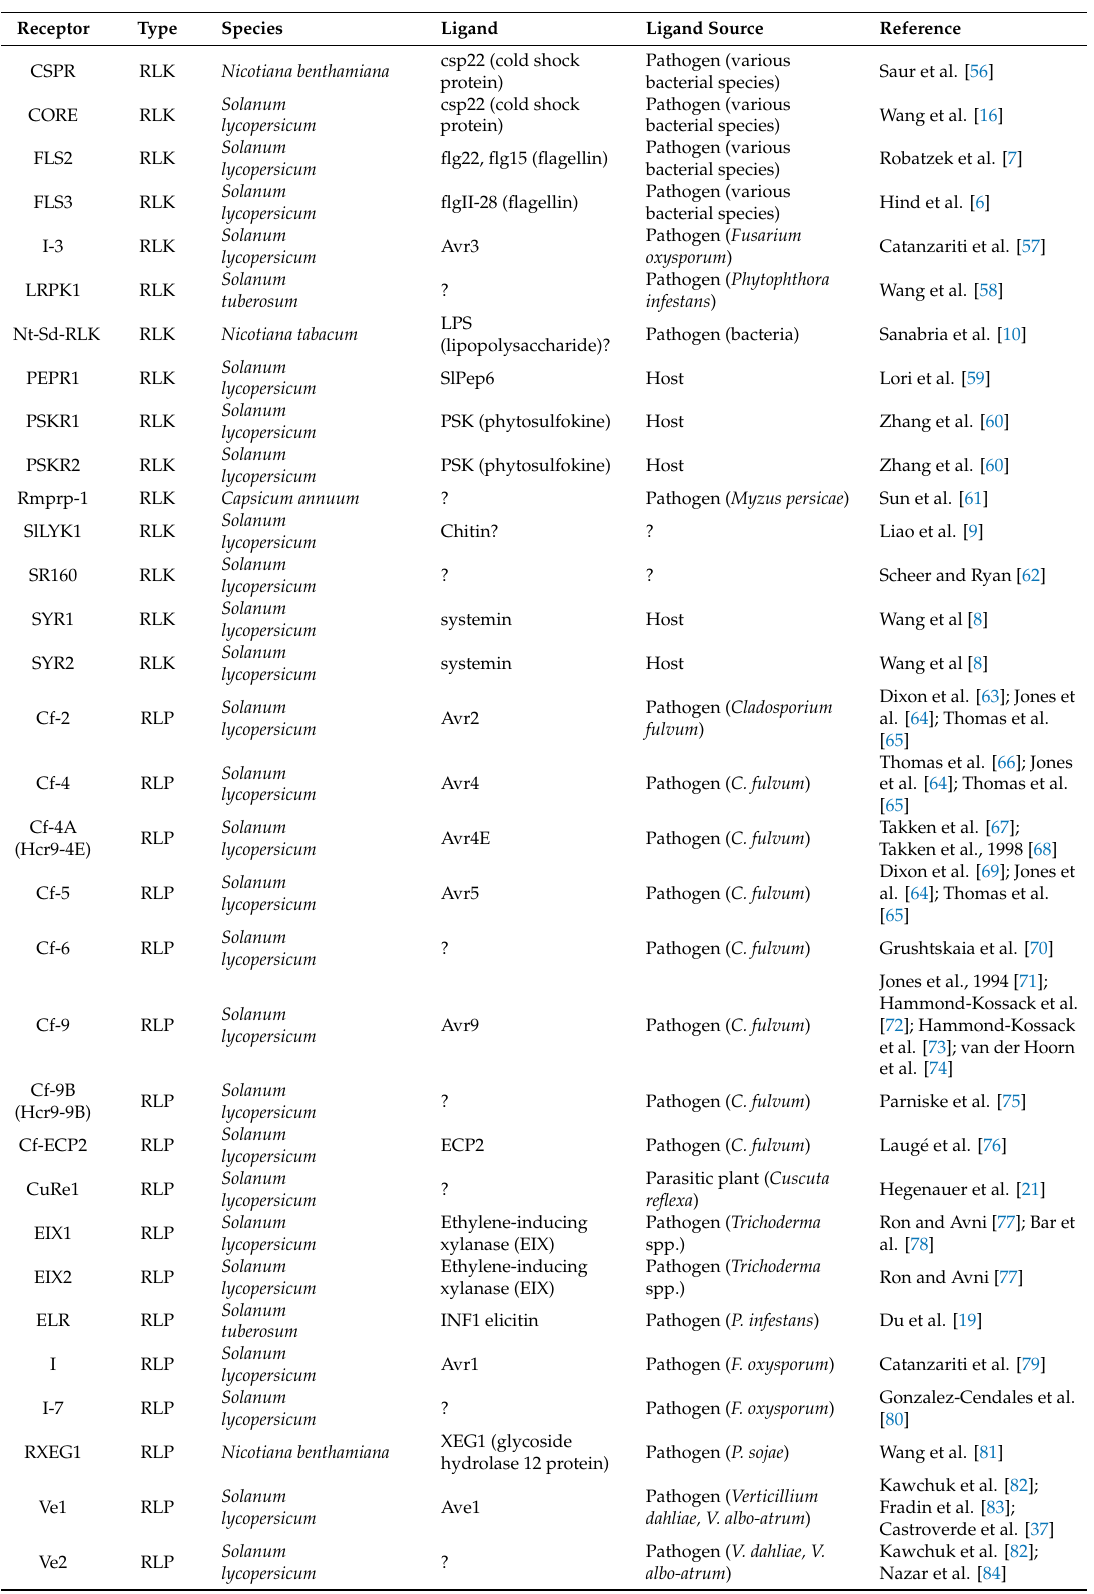
Table 1. Known cell surface immune receptors proteins in plant species of the Solanaceae family.